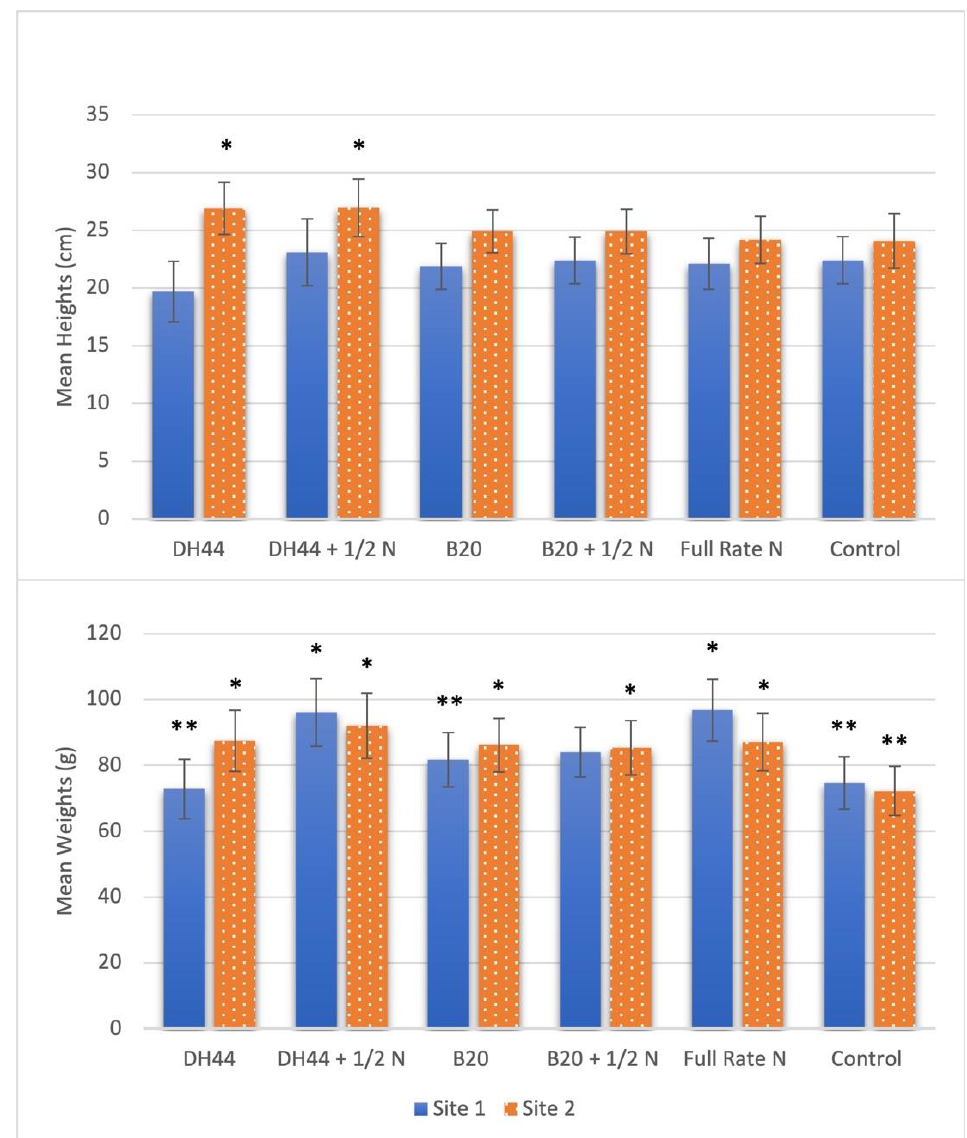
Figure 1. Mean forage yield (heights and weights) of bermudagrass plots harvested over two years from two sites in Alabama. Treatments included rhizobacterial inoculants (DH44 and B20) and those rhizobacteria applied with 56 kg N/ha (1/2 N). Treatments were compared to a full rate of nitrogen fertilizer (112 kg N/ha) as a positive control and a non-treated, negative control. “*” indicates significance from control (non-treated). (Orthogonal contrast, p ≤ 0.05). “**” indicates significance from full-rate N. (Orthogonal contrast, p ≤ 0.05).